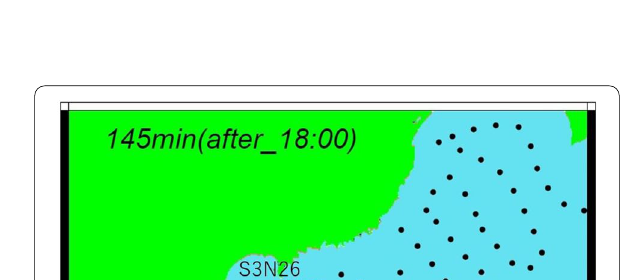
p b = p w + p 0 where p w = ρ gh .